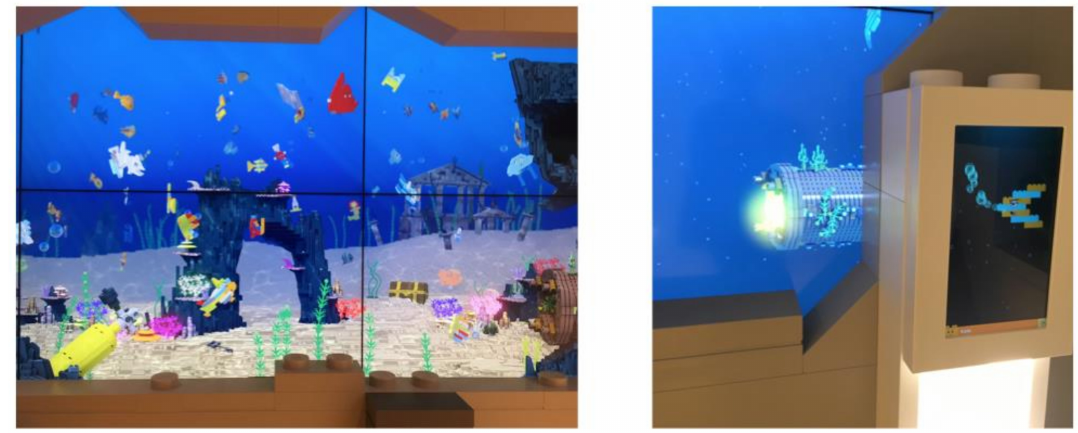
Figure 7. Virtual aquarium ( left ) and digital fish swimming from the capture station ( right